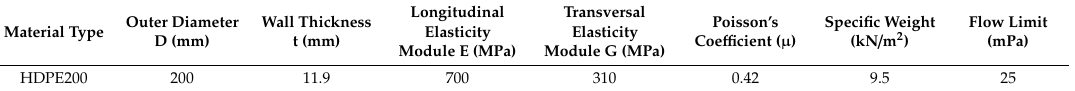
Table 1. Mechanical and elastic features of high-density polyethylene (HDPE) material.